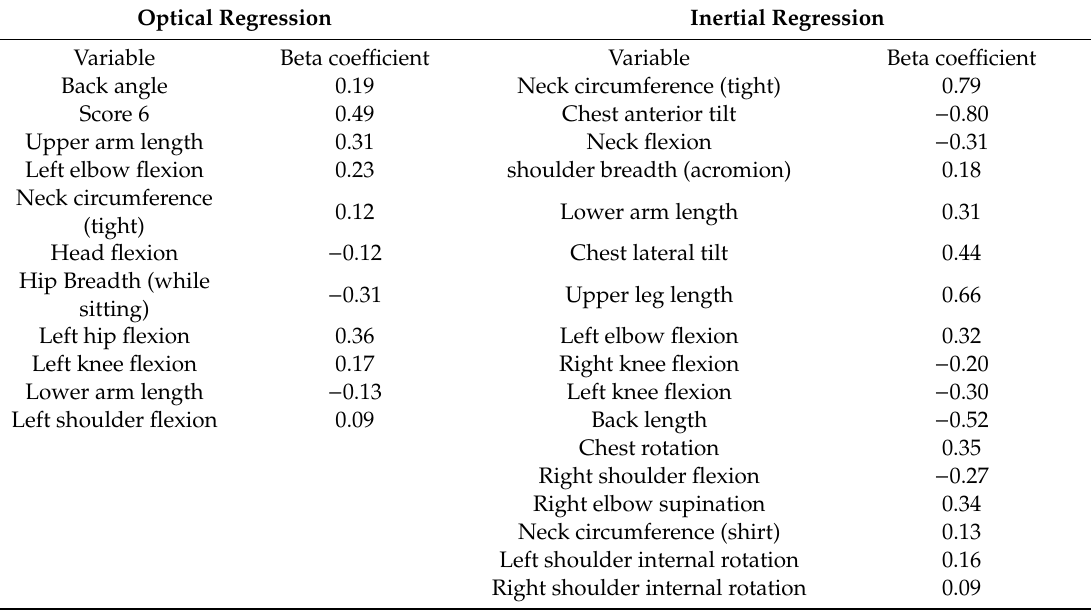
Table 4. Standardized beta coe ffi cients for the included variables in the regression model based on the optical and inertial mocap data.